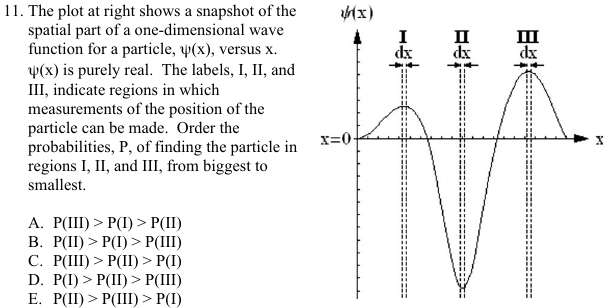
FIG. 4. Question 11, taken from the QMVI, tests student under- standing of the relationship between wave function and